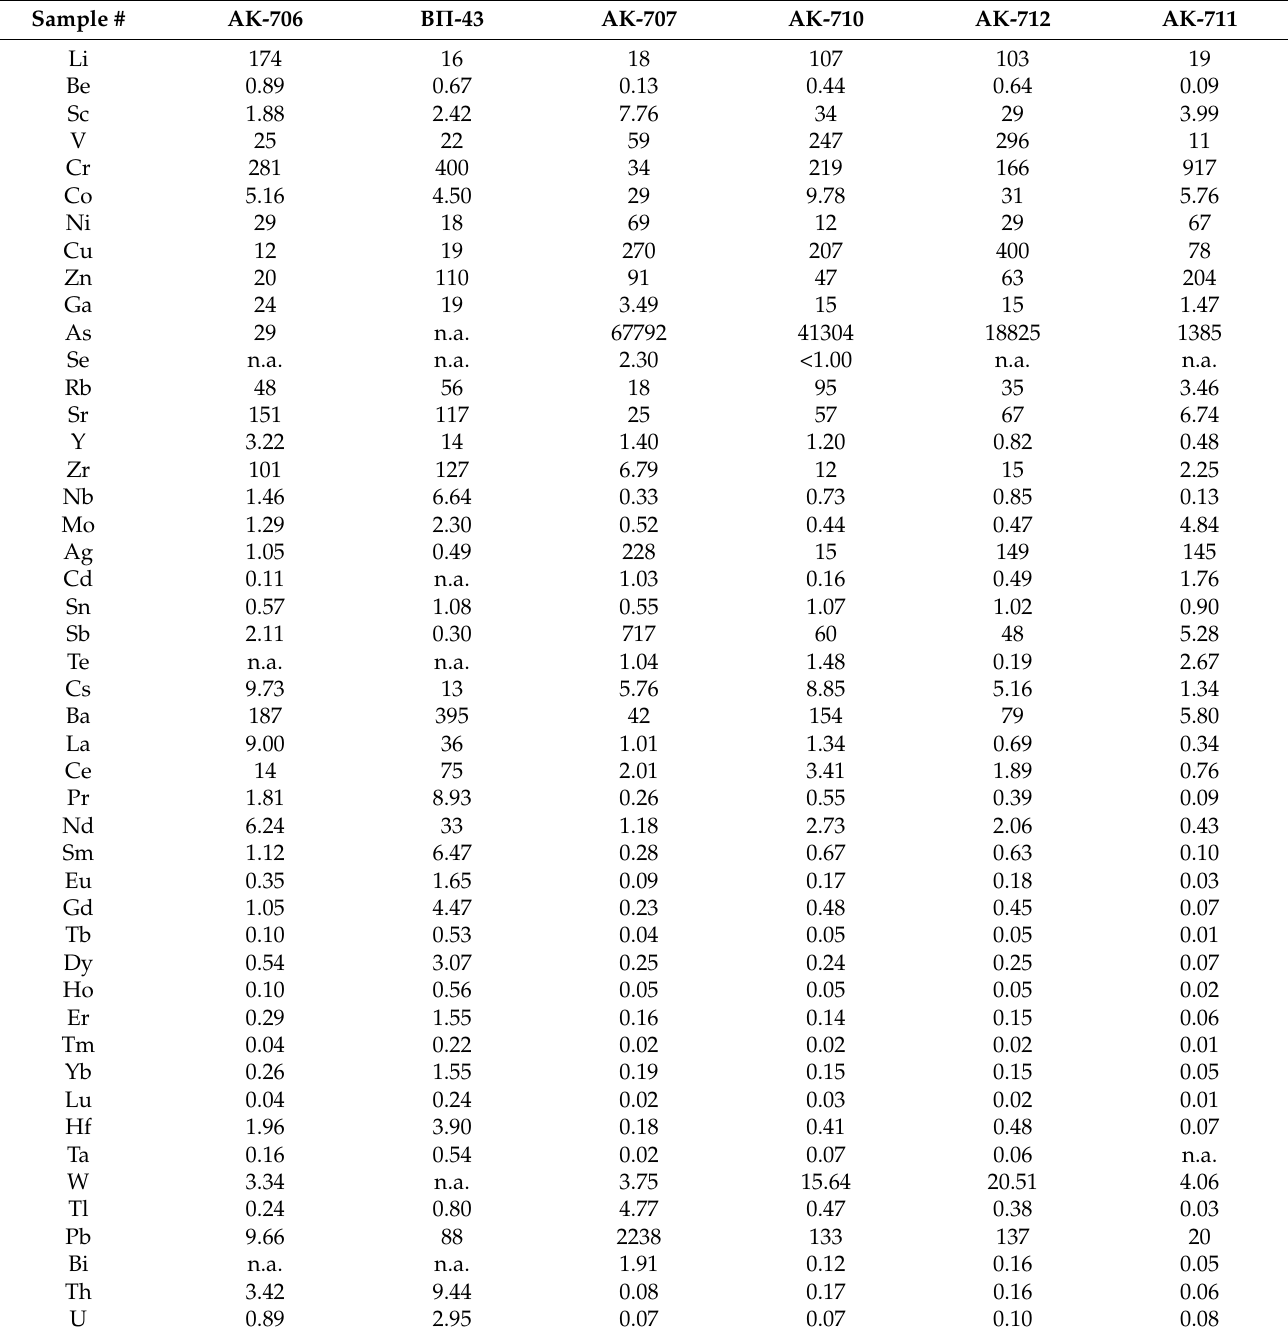
Table 5. ICP-MS data for granite porphyry and altered rocks of the Oleninskoe deposit,